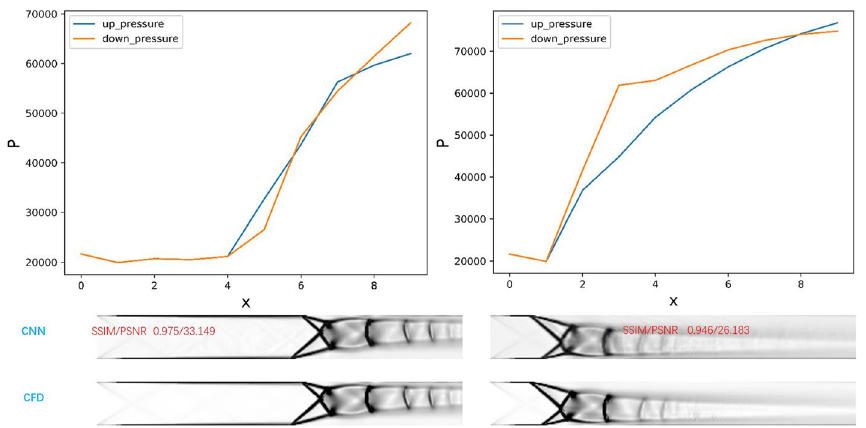
Fig. 8 Comparison between reconstructed flow field image based on CNN (middle) and CFD calculated flow field image